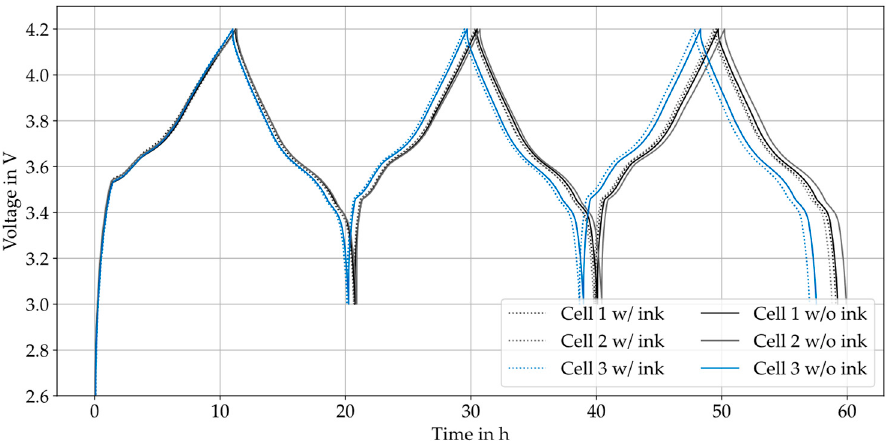
Figure 9. Voltage profiles of the six coin cells during formation; the curves of the coin cells with ink are shown in dots, whereas the curves of the cells without ink are depicted with solid lines.